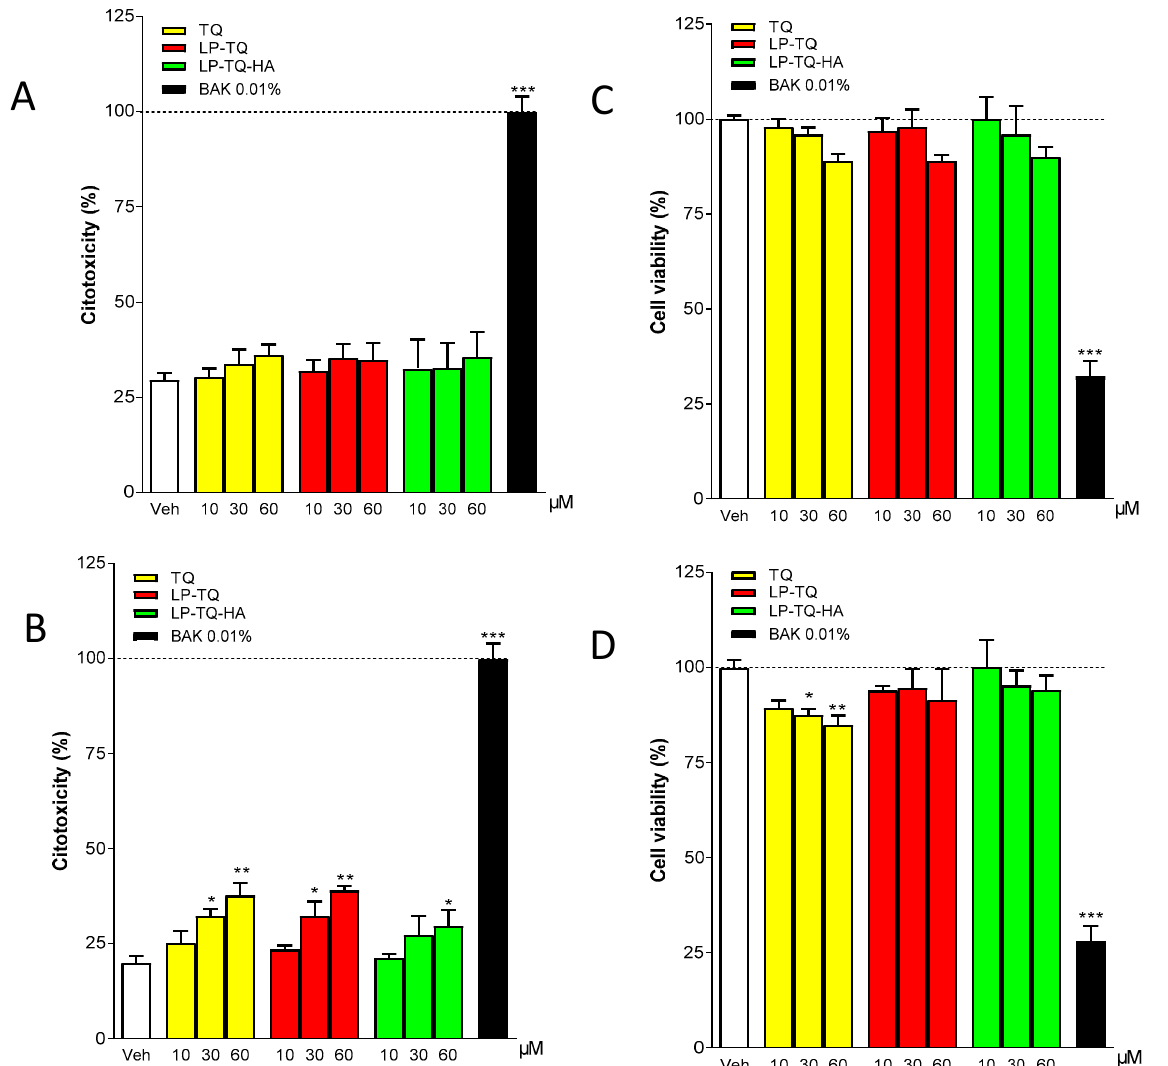
Figure 4. Evaluation of LDH and MTT assay in the human corneal epithelial cells (HCE-2) after 15 min ( A , C ) and 1 h ( B , D ) of incubation with TQ, LP-TQ, or LP-TQ-HA components. Data are expressed as percentages of the maximum degree of cell death BAK ( A , B ) and as percentages of the maximum cell viability (Veh) ( C , D ); they represent the mean ± standard error of the mean of at least 3 experiments performed in triplicate. * p < 0.05, ** p < 0.01, and *** p < 0.001 vs.